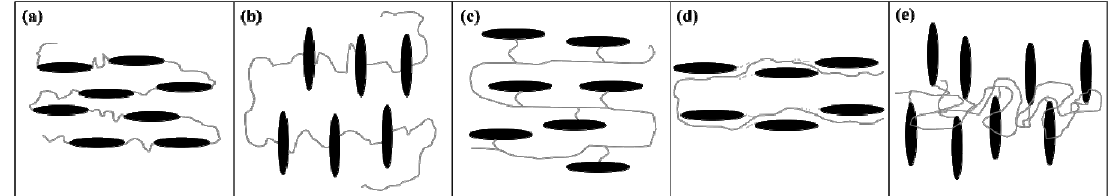
Figure 1. Polymer chain conformations and mesogens (dark ellipses) organization depend on the length, flexibility, number (even/odd) of carbons in the spacer, the type of attachment (side-on or end-on), and interaction among them. Several possible scenarios are shown for, both, the main-chain and side-chain liquid crystal elastomers (LCEs): ( a , c , d ) Mesogens lying parallel to the polymer backbone favoring prolate conformation; and ( b , e ) Polymer backbone perpendicular to mesogens adopts an oblate